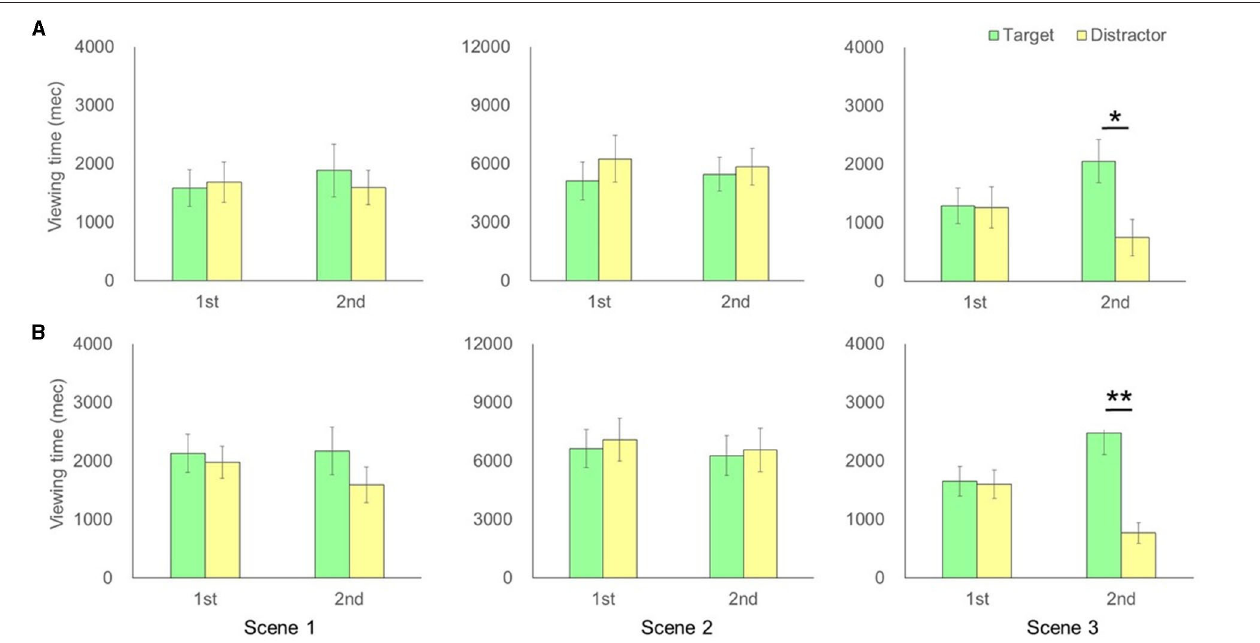
FIGURE 2 | (A) Comparison of time for each actor between the first and second viewing for the Alzheimer’s disease group in each scene of the video clip. (B) Comparison of time for each actor between the first and second viewing for the normal elderly control group in each scene of the video clip. The error bar represents standard errors. P -values represent the results of a post-hoc test after detection of marginal significance or significant interactions in the ANOVA test. ** p < 0.01, * p <